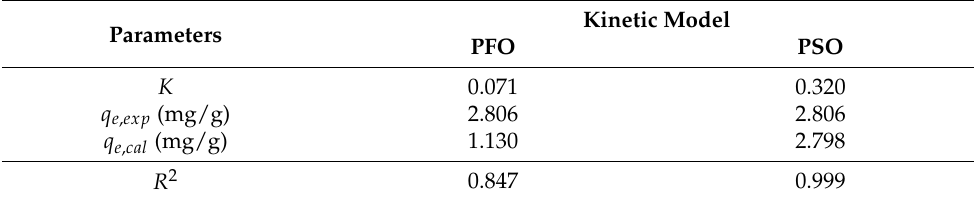
Table 2. Kinetic model parameters for the adsorption of AR1 dye using PMG50 composite.